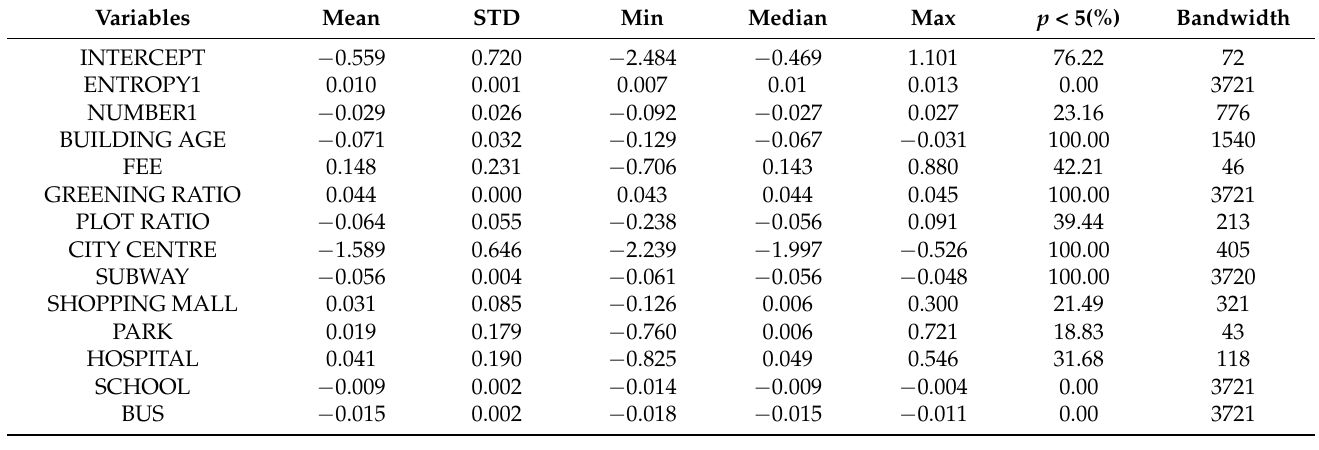
Table 4. MGWR model results of Model 1.